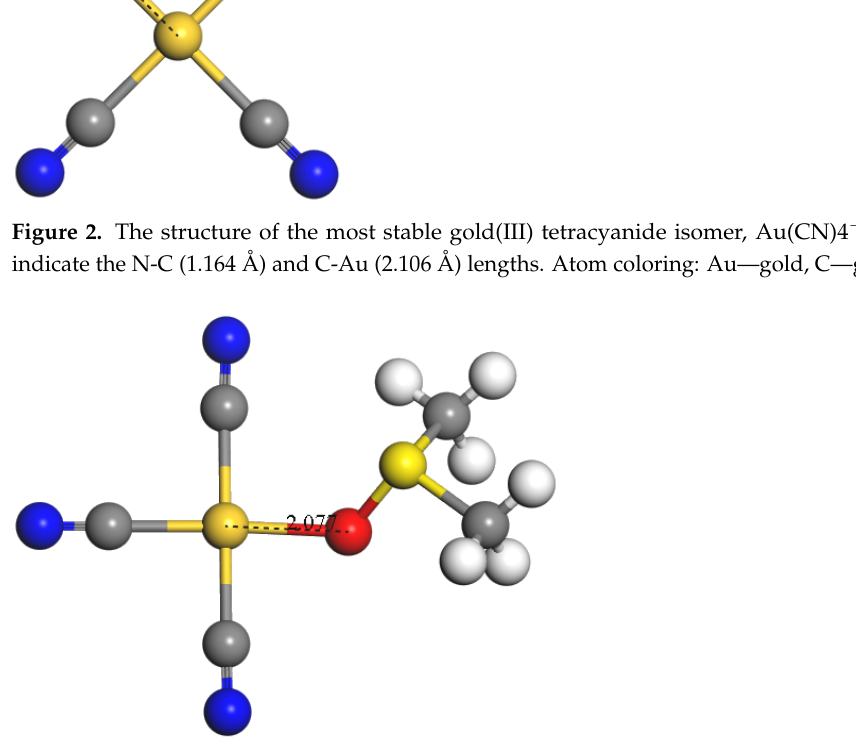
Table 3. Energy (E); energy corrected by the zero ‐ point vibrational energy (E + ZPVE); Gibbs free energy ( Δ G) of the complex formation of gold(III) tricyanide dimethyl sulfide complex. In vacuo— results obtained without solvation. DMSO—results obtained using PCM implicit solvation model. All values are in kcal/mol.